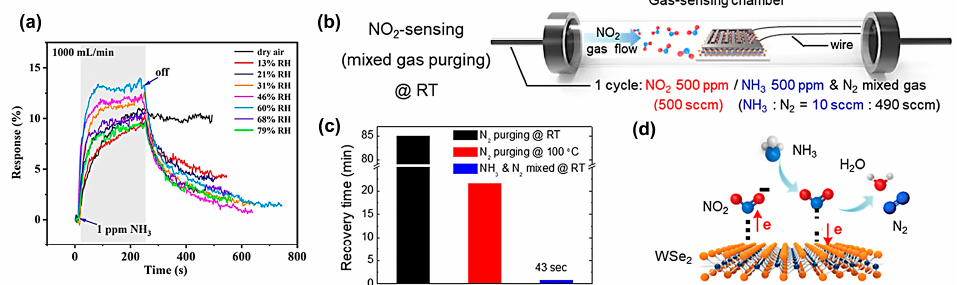
Figure 13. Performance of the N-MXene sensor: ( a ) humidity effect on sensor response toward 1 ppm of NH 3 . Reprinted with permission from Ref. [175]. Copyright 2021, American Chemical